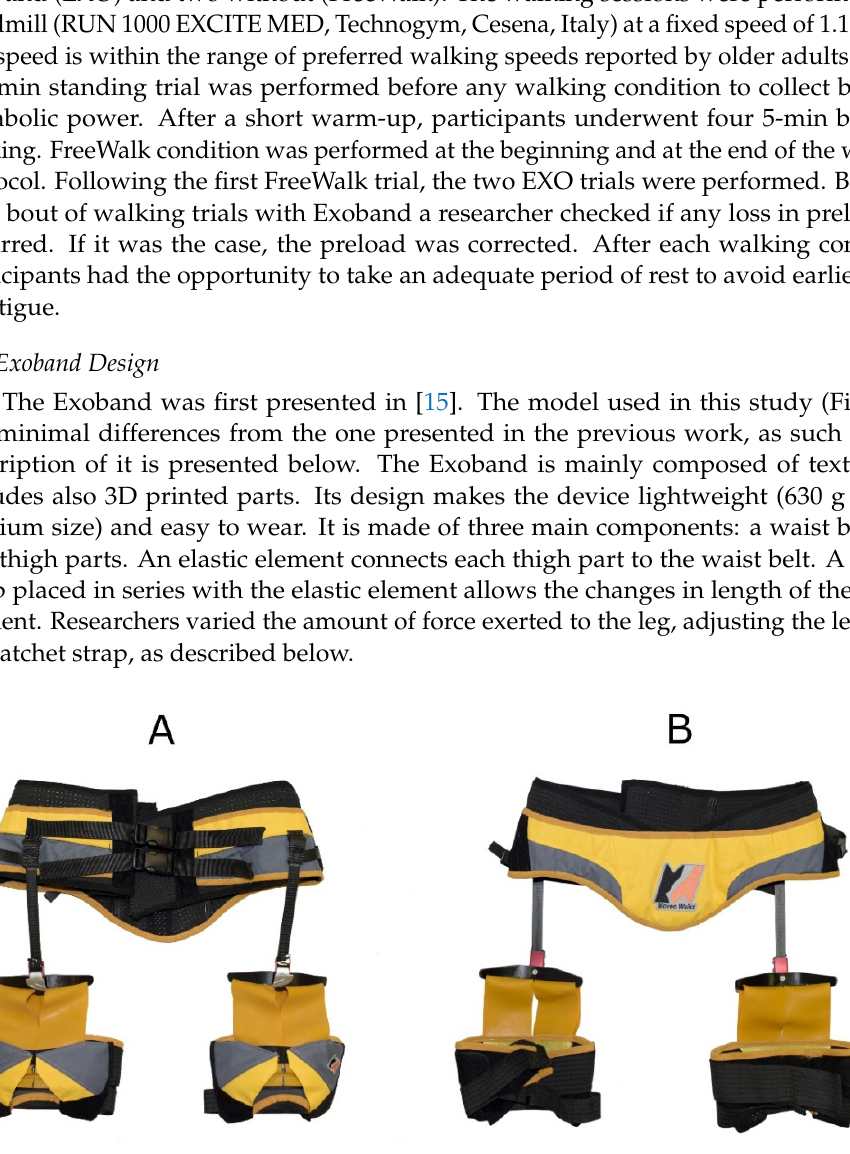
Figure 1. Front ( A ) and rear ( B ) view of Exoband, the passive device employed in the study.